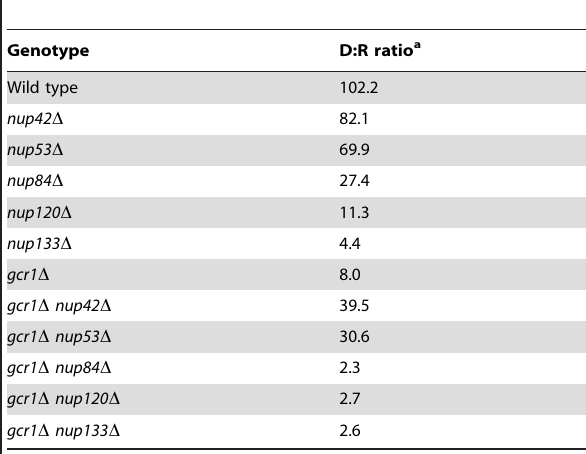
Table 1. Deletion of nucleoporins compromises regulation of SUC2 expression.